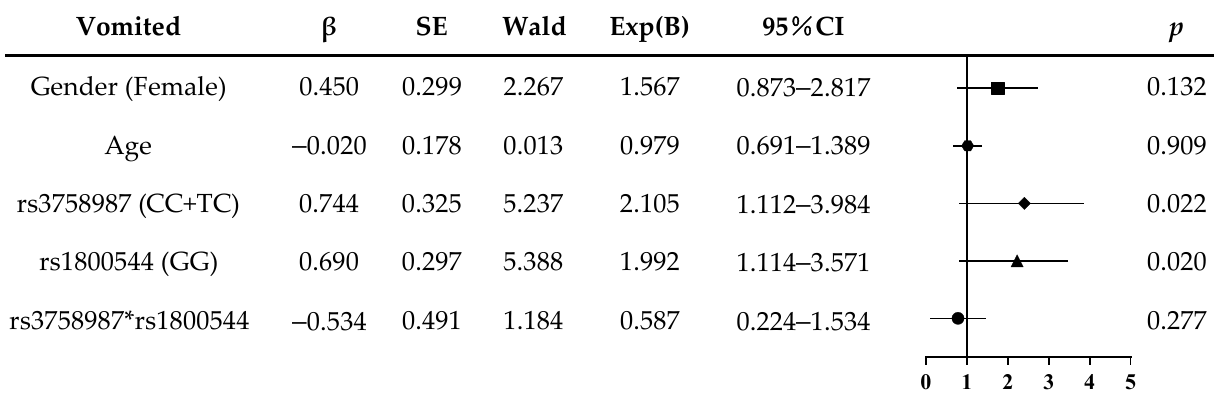
Figure 1. Logistic regression analysis of risk of motion sickness susceptibility in subjects.